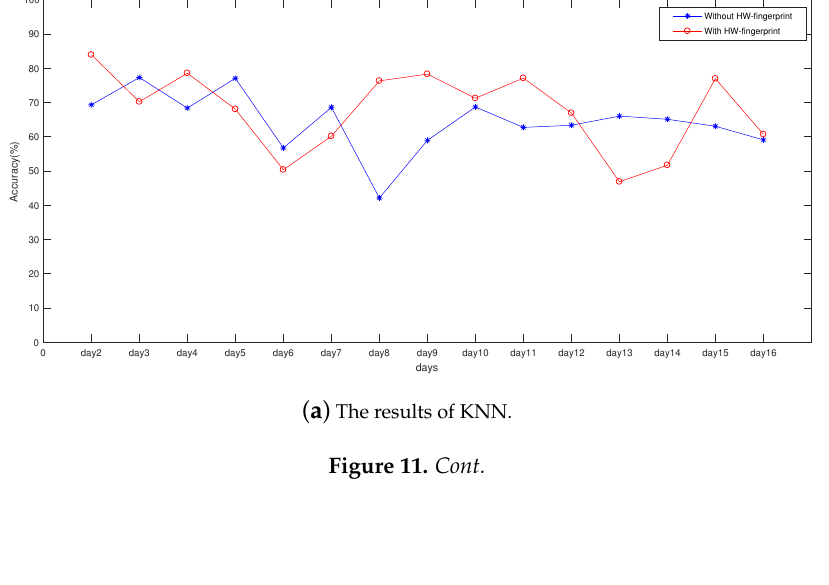
( a ) The results of KNN. Figure 11.